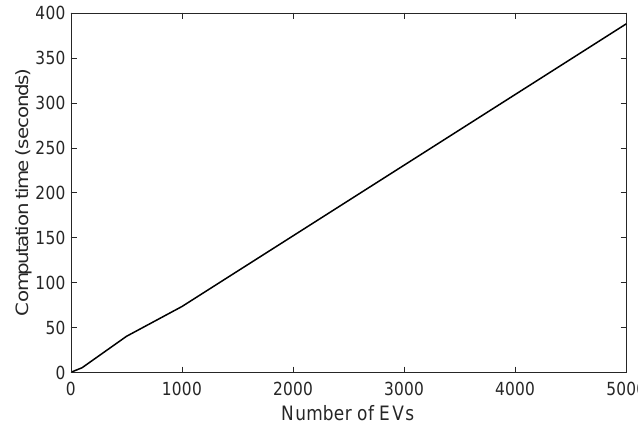
Figure 4. Computation time as a function of the number of electric vehicles (EVs).